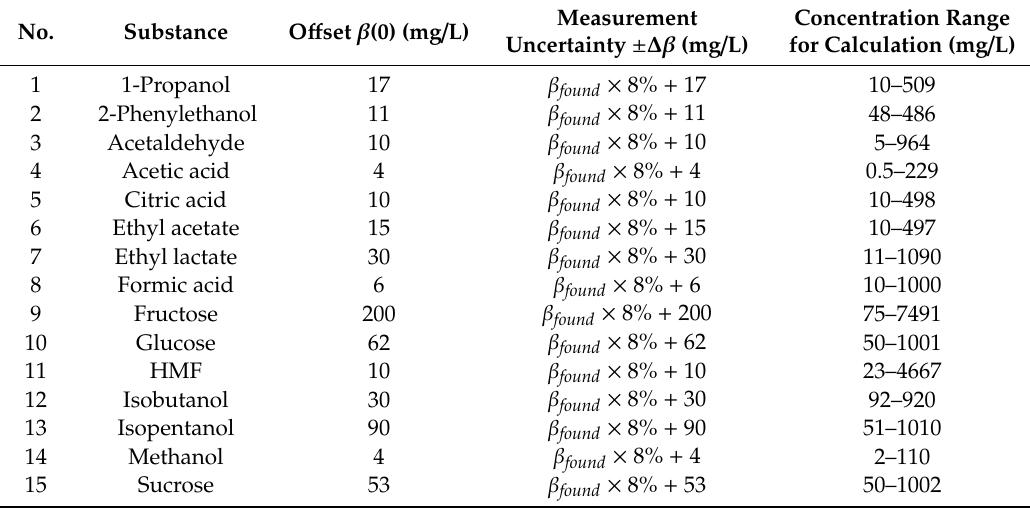
Table 5. Measurement uncertainties of analytes in spirit